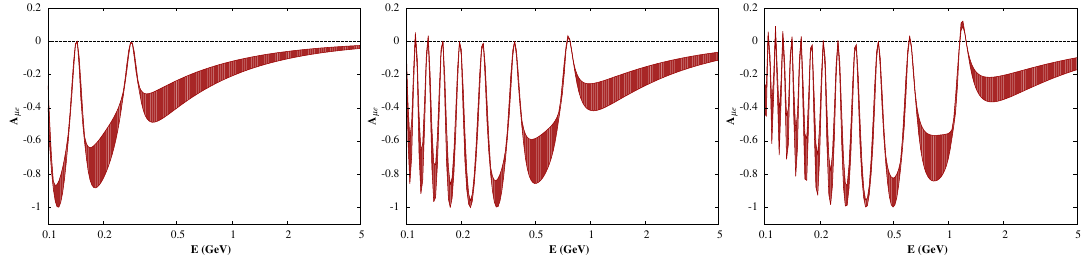
Figure 6 . Plots of the CP asymmetry parameter ( A (cid:22)e ) with energy E for (cid:12)xed baseline lengths corresponding to di(cid:11)erent experiments in case of NO. Figure (a) is for T2K with L = 295Km; (cid:12)gure (b) is for NO (cid:23) A with L = 810Km and (cid:12)gure (c) is for DUNE with L = 1300Km. The plots and their widths have same speci(cid:12)cations as in (cid:12)gure 5. The horizontal lines denotes CP conservation ( A (cid:22)e =